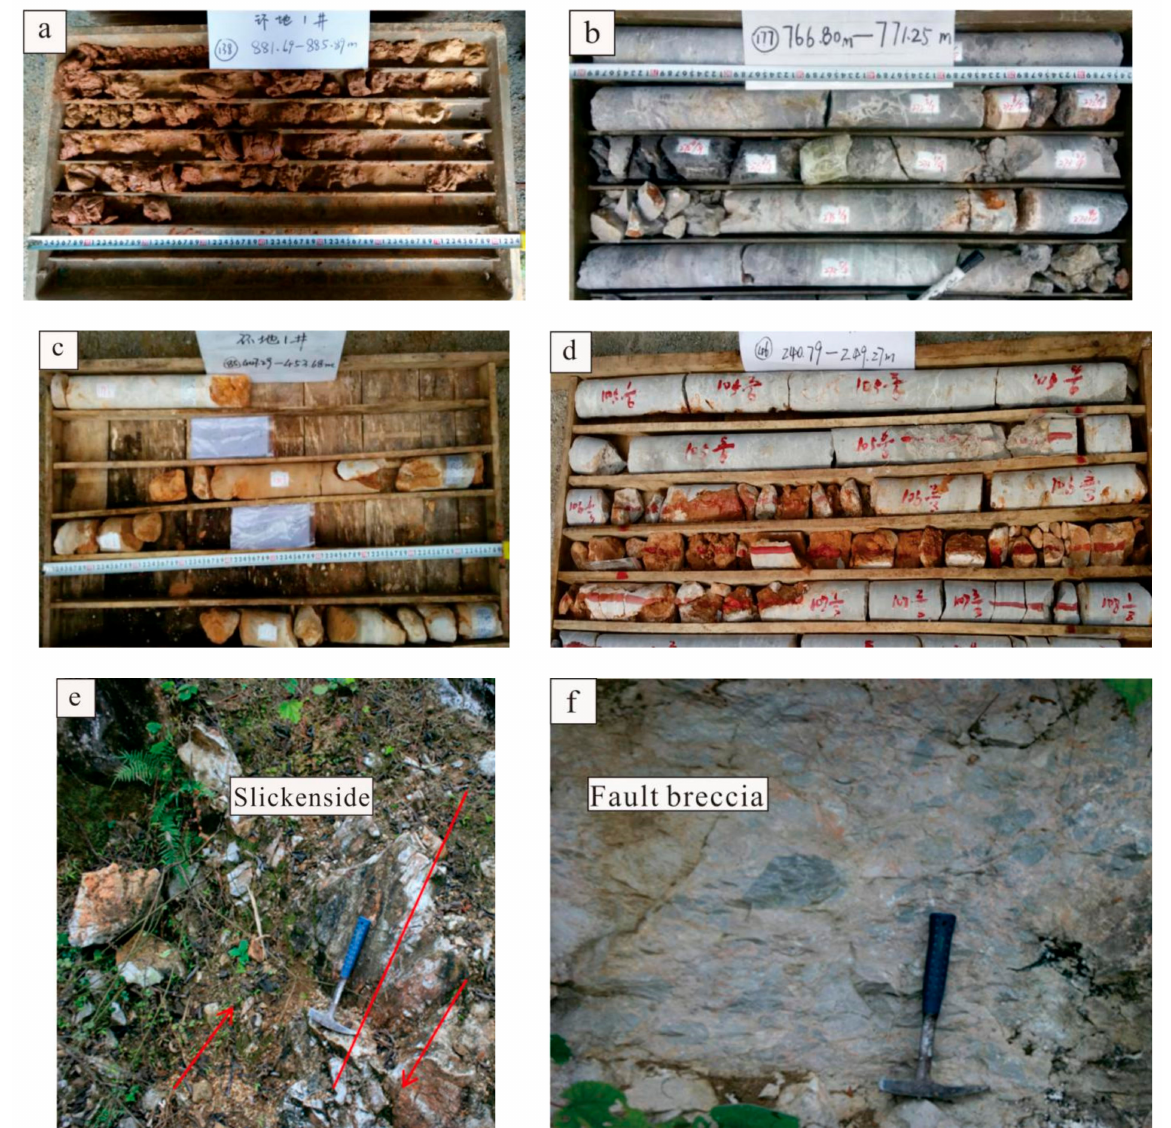
Figure 3. Characteristics of karst development of a single well. ( a ) Cave filled with clay, 881.69–885 m, HD1-2 well. ( b ) The reticular cracks, 766.8–771.25 m, HD1-2 well. ( c ) Caves, 447–453 m, HD1-4 well. ( d ) Cracks filled with clay, 240–249 m; surface fault mark near the well: ( e ) slickensides and ( f ) fault